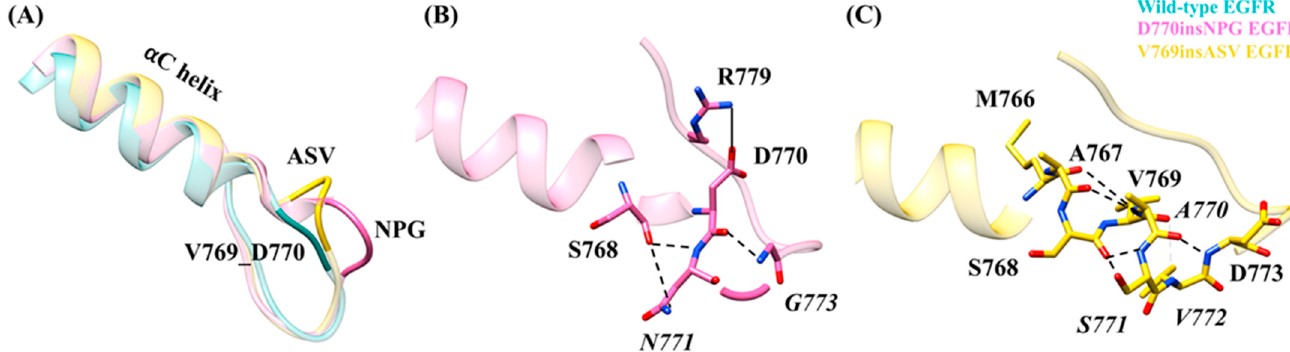
Figure 9. Inactive EGFRs: Structural changes and interactions in D770insNPG and V769insASV at the site of the insertion mutations. ( A ) Superimposed starting structures of wild-type, D770insNPG and V769insASV inactive EGFRs, highlighting the location of the insertions. Interactions involving the inserted residues in the inactive ( B ) D770insNPG and ( C ) V769insASV EGFRs. The frequently formed D770–R779 interaction in D770insNPG EGFR is also shown.